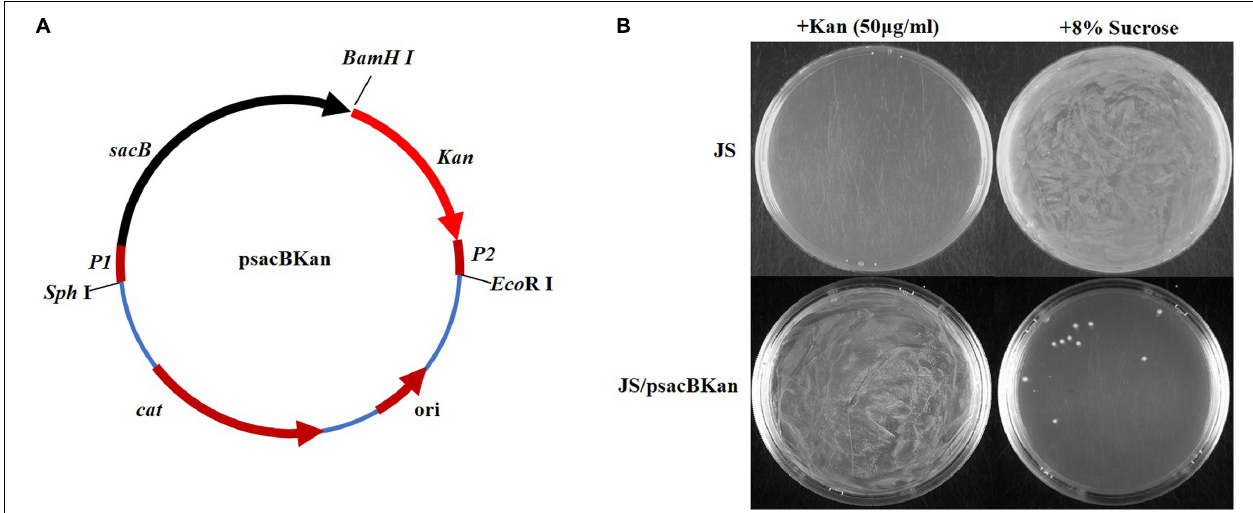
FIGURE 2 | Construction and functional identification of plasmid psacBKan. (A) sacB , levansucrase-encoding gene is synthetic; Kan, kanamycin-resistant gene results from vector pET30a. P1/P2 sequence fragment is the common template of primers H1P1/H2P2. Other components come from the low-copy-number vector pSTV28 (TaKaRa): cat, chloramphenicol resistance gene; ori, replication origin. (B) Functional identification of scaBKan cassette on the low-copy-number vector pSTV28. Kanamycin and sucrose sensibility of WT strain JS and the derivative strain JS/psacBKan are identified on LB plate with 50 µ g/ml kanamycin or 8%